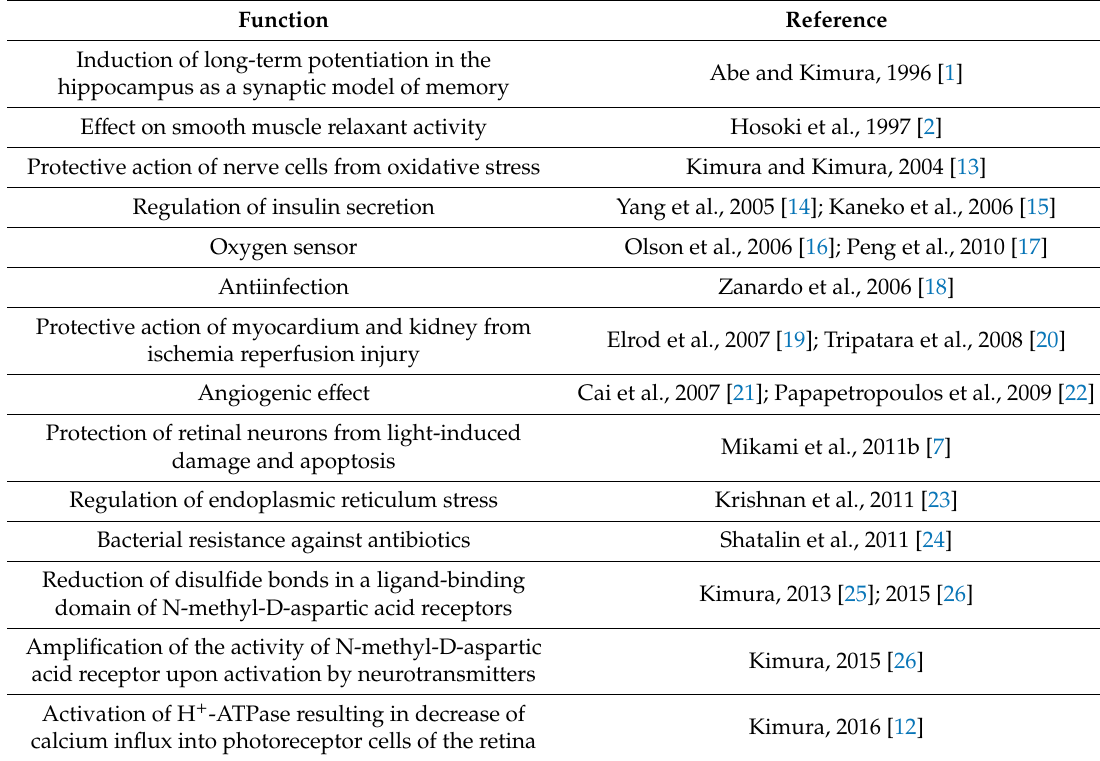
Table 1. Physiological function of H 2